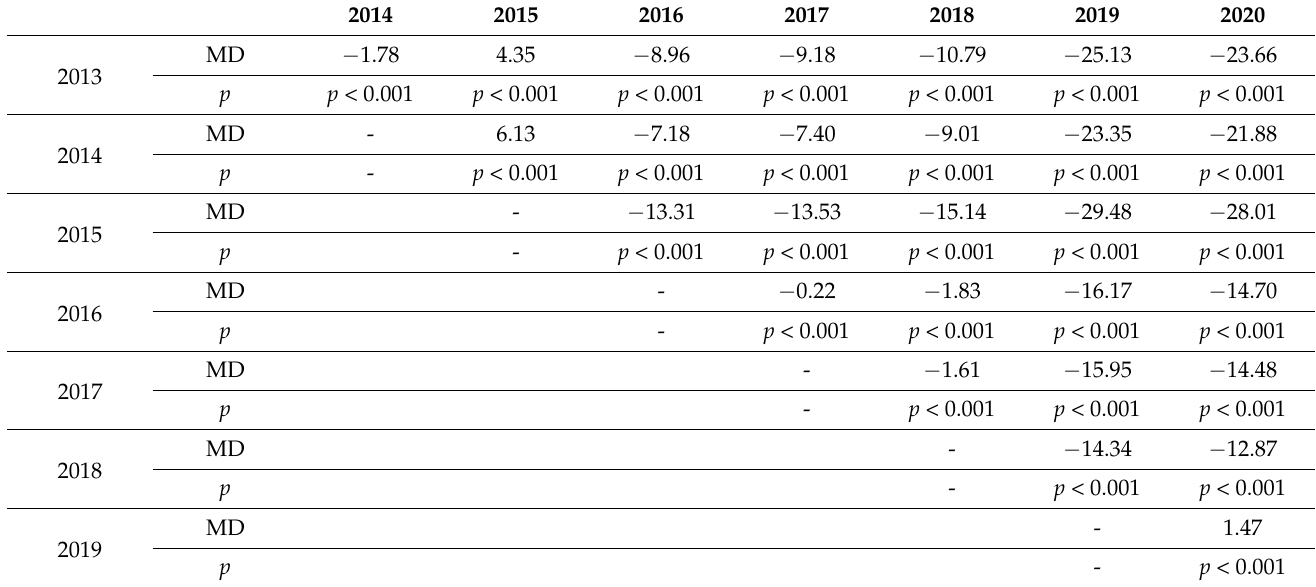
Table 15. Comparison of the use of SAD between individual editions of the